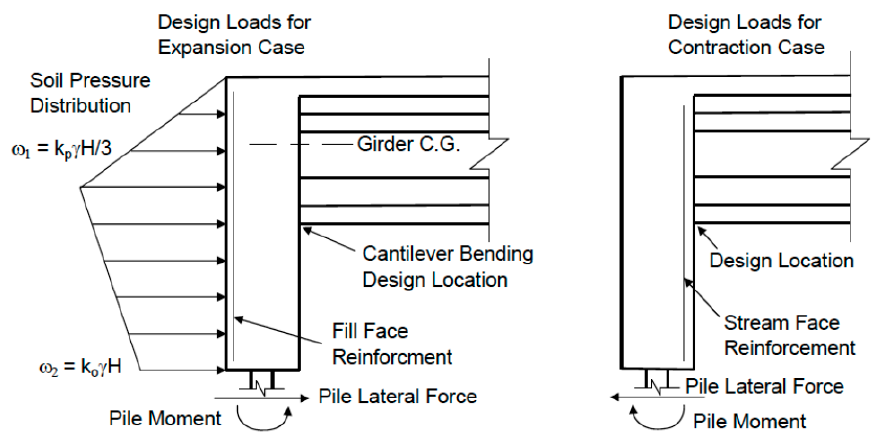
Figure A1. Earth pressure on integral abutment during bridge expansion and contraction—Idaho DOTs [32].